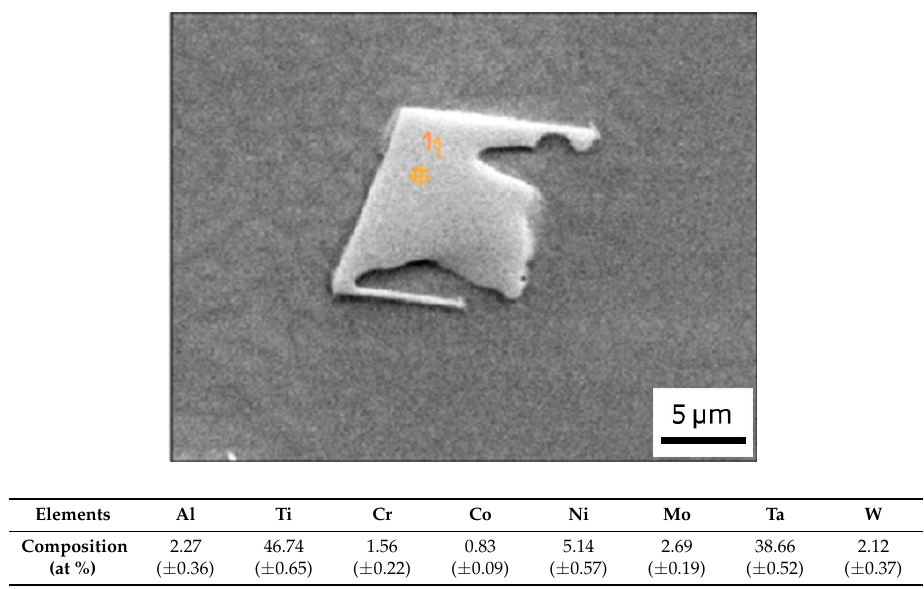
Figure 4. Energy dispersion spectroscopy (EDS) data (average of 10 measurements) reveal that it is rich in Ti and Ta.